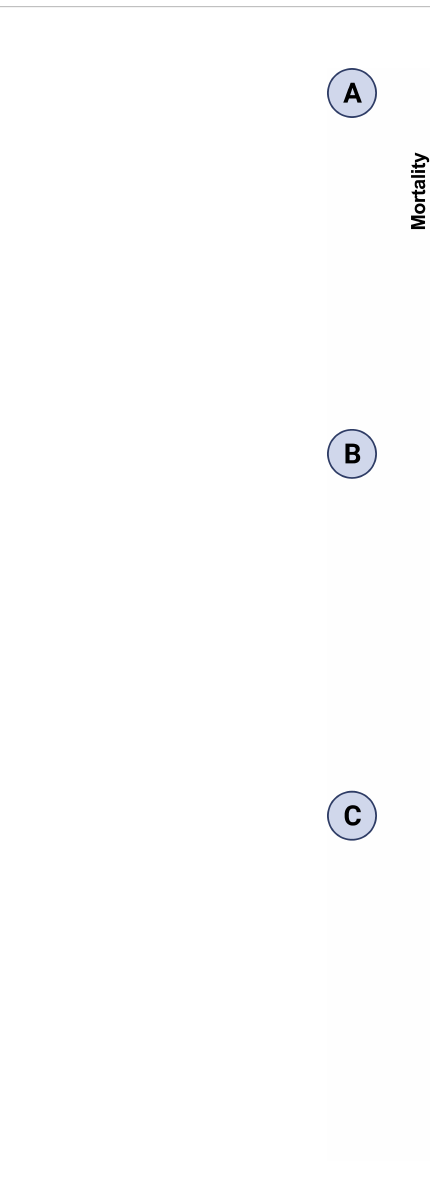
FIGURE 6 Regression analysis and prognostic performance of sFasL for COVID-19 mortality. (A) Regression analysis showed lower sFasL is associated with an increased risk for mortality (n =66). (B) AUC in ROC was 0.70. (C) sFasL levels were lower in dead compared to alive COVID-19 patients. *p<0.05, **p< 0.01, ***p<0.001, ****p<